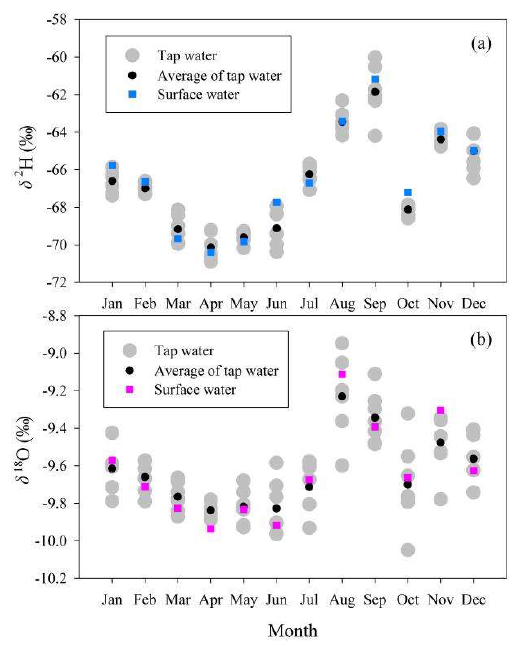
Figure 9. Comparison of temporal variations of δ 2 H ( a ) and δ 18 O ( b ) in tap water with those in surface water. The monthly data of δ 2 H and δ 18 O in tap water at 7 sampling sites and those in surface water at the site of Zhongshan Bridge (S-1) are both between March 2016 and February 2018. Table 3. Seasonal and annual mean values of δ 2 H and δ 18 O in precipitation and surface water and their standard deviations (SD) in Lanzhou.